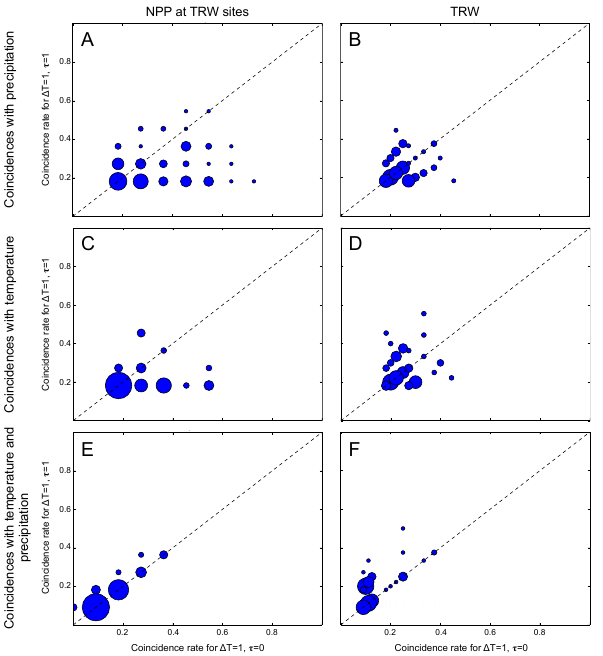
Figure 7. Instantaneous ( r calculated for (cid:49)t = 1 and τ = 0, x axis) vs. lagged ( r calculated for (cid:49)t = 1 and τ = 1, y axis) coincidences of extreme events. The size of the dots is proportional to the amount of significant coincidences, i.e. larger dots indicate a higher number of sites/grid cells with significant coincidences. Note that the reg- ular grid of coincidence rates results from consistent time series length for simulated NPP, while the length of the time series for TRW